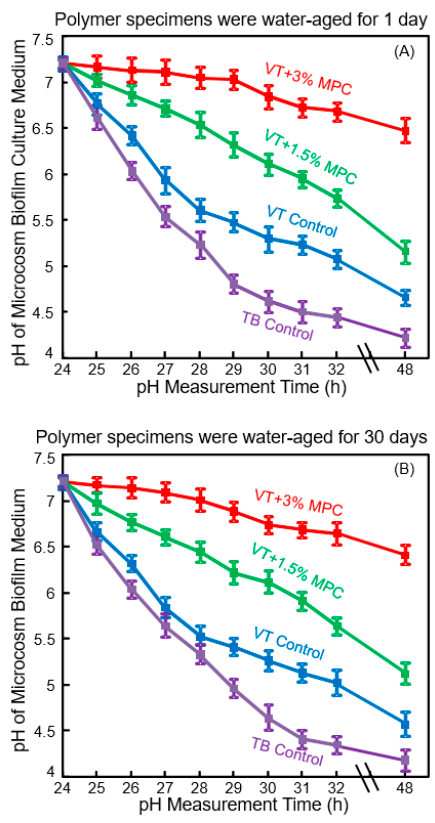
Figure 4. Protein-repellent and antibacterial orthodontic cement. Effect of MPC incorporation on the decrease in pH of culture medium with dental plaque microcosm biofilms: ( A ) pH of medium with biofilms on orthodontic cement disks after being water-aged for 1 day, and ( B ) pH of culture medium with biofilms cultured on the orthodontic cement disks after being water-aged for 30 days. (Reproduced with permission from [66]. Wiley,